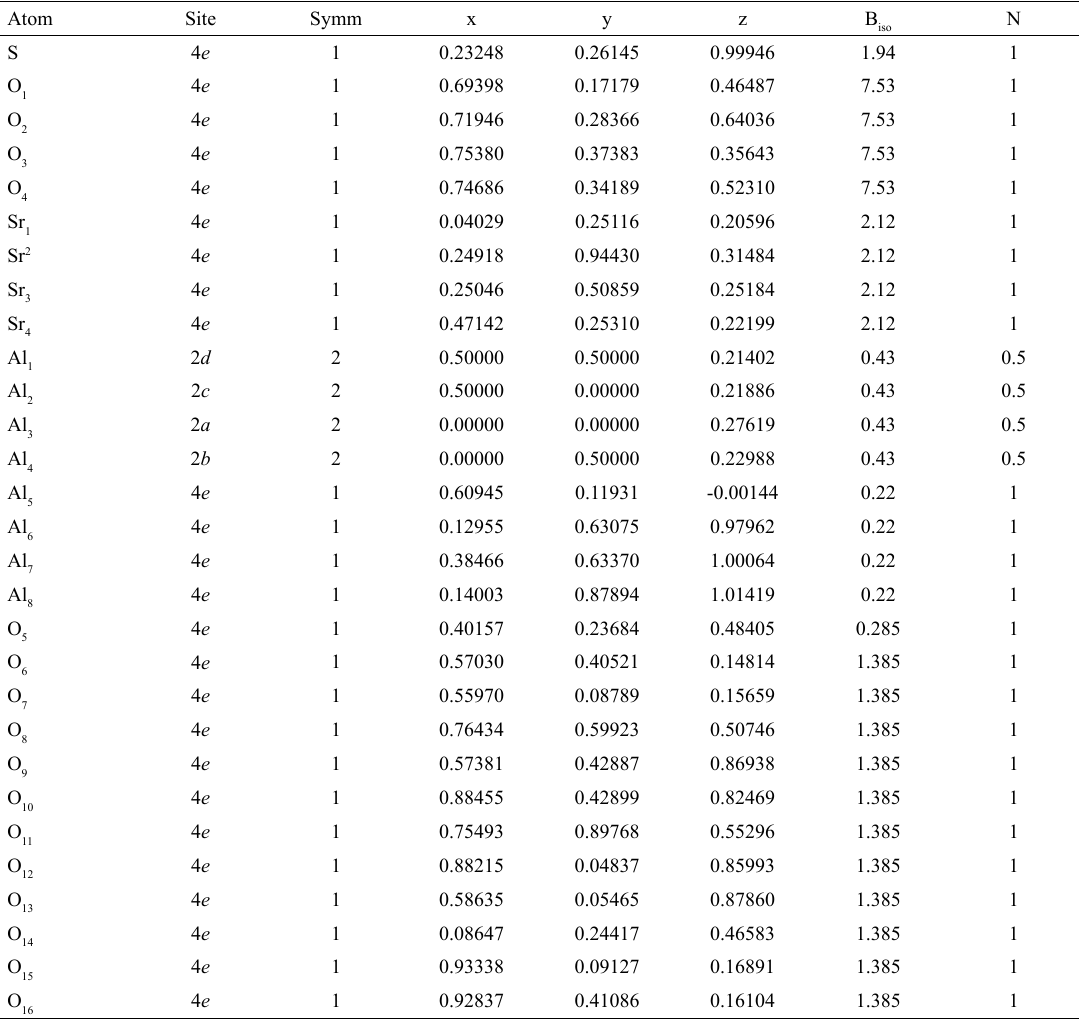
Al O SO 4 6 12 4